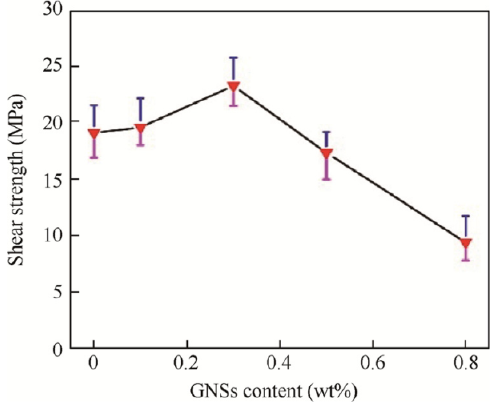
Figure 10: Effect of GNS content on the shear strength of joints (T=880 ∘ C, t=10min).